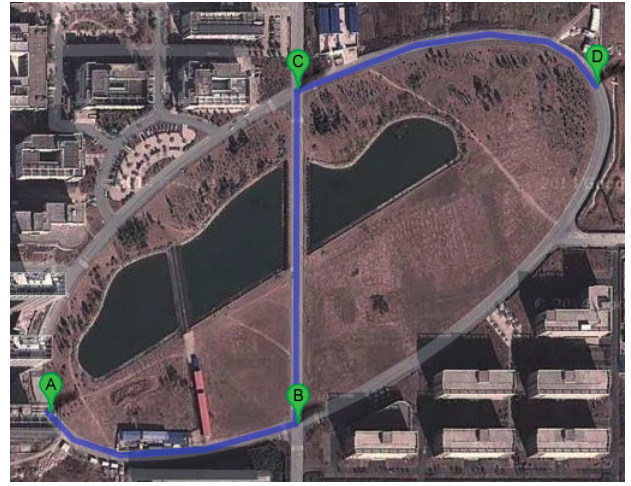
Figure 8. The ring road in the